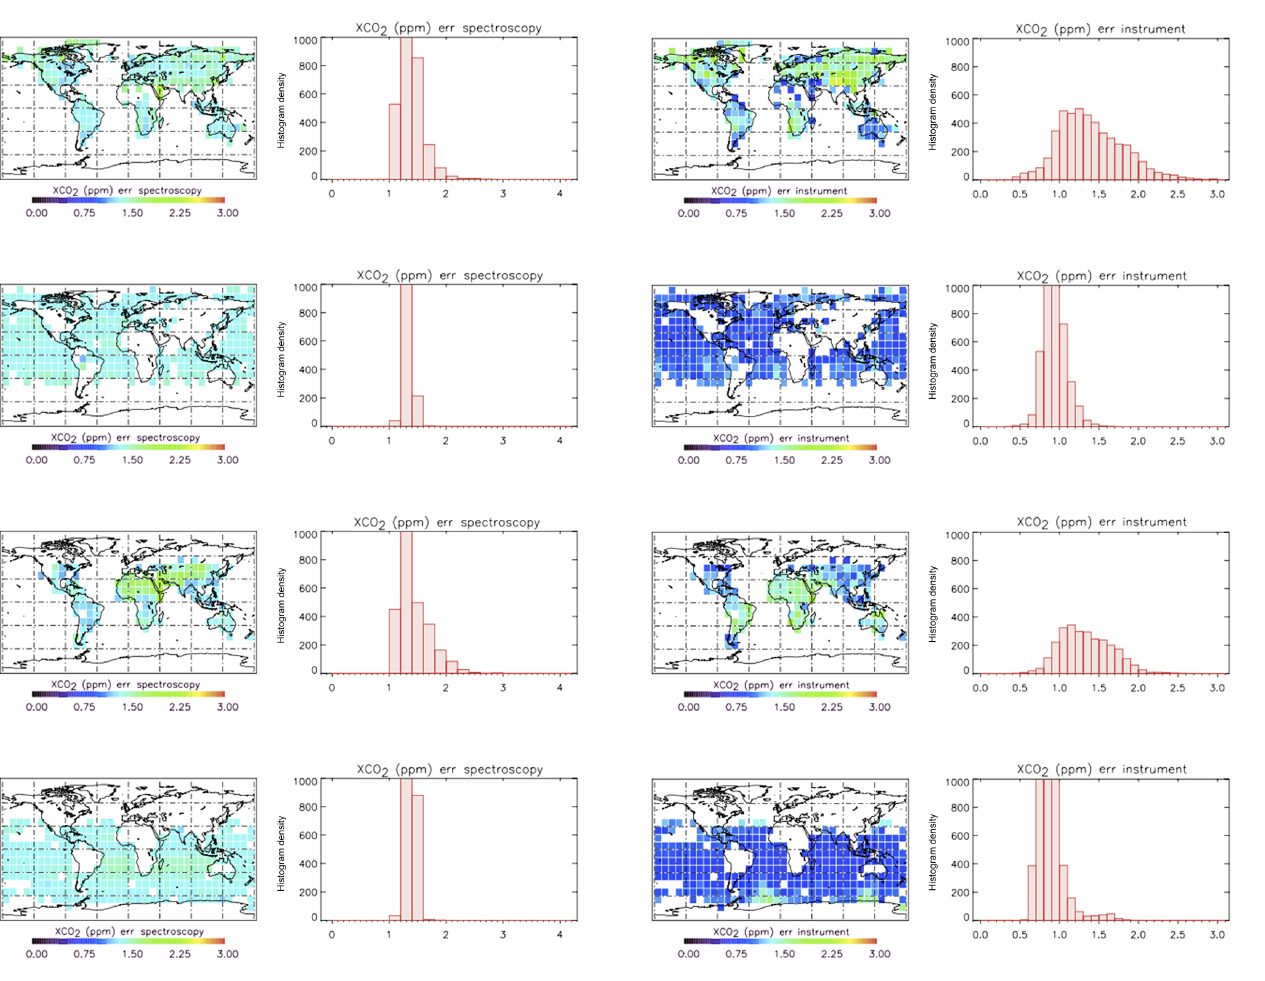
Figure 3. Instrument error. Top: June, land; second row: June, ocean; third row: Dec., land; bottom: Dec.,